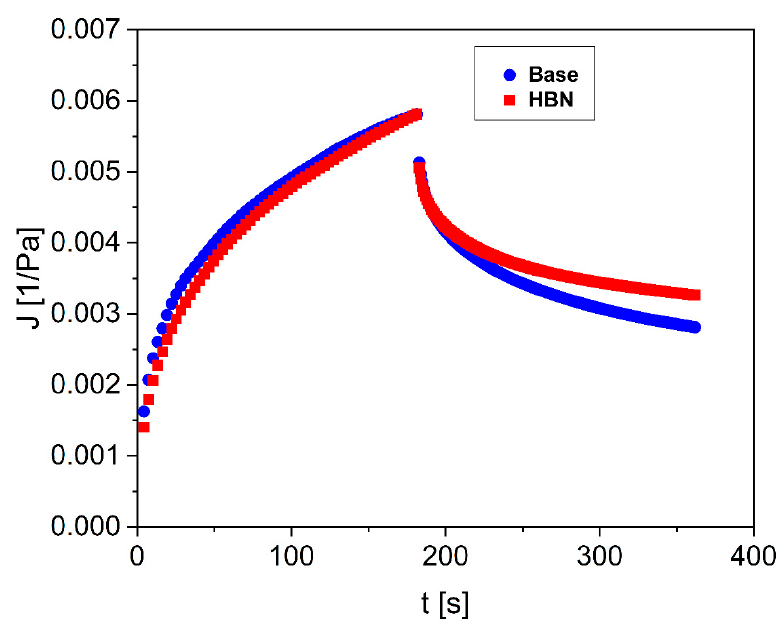
Figure 6. Creep-recovery curves of the control and the formulation. The change in compliance versus time is illustrated. Error bars were always lower than 10%. The error bars are omitted for clarity purposes. The experiments were repeated three times.